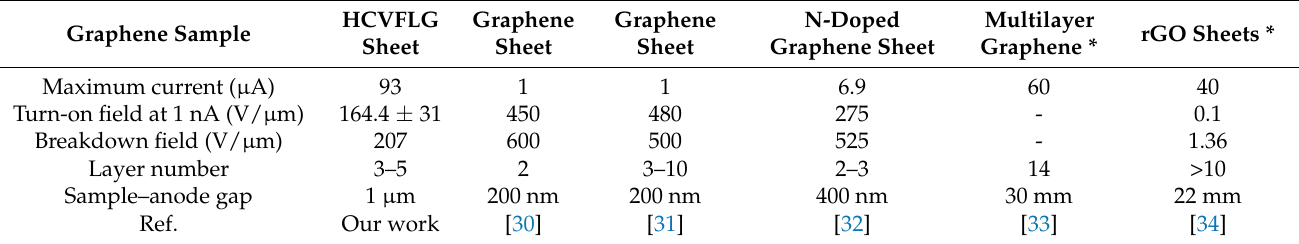
Table 1. Comparison of the field emission characteristics of HCVFLG and the reported graphene